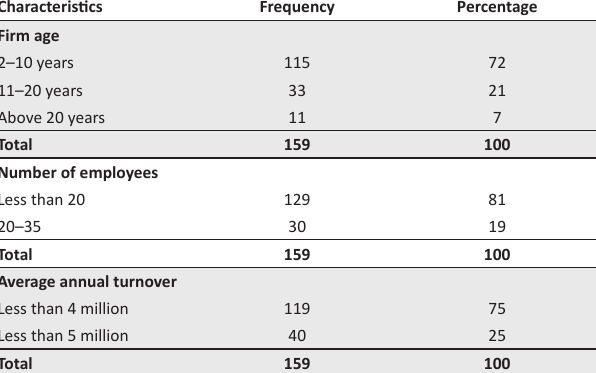
TABLE 1b: Sample small- and medium-sized entity profile characteristics. Characteristics